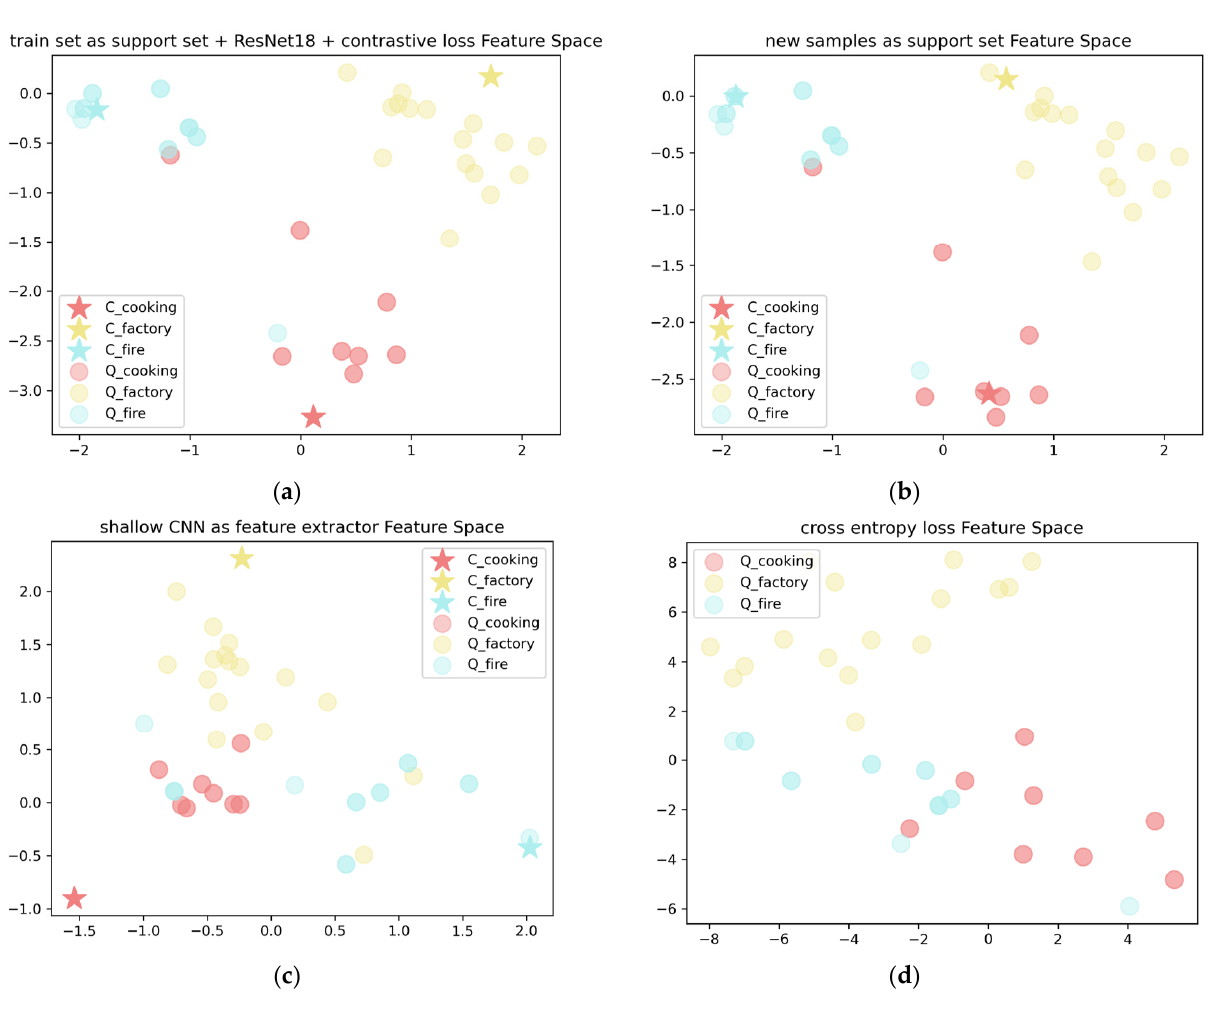
Figure 13. The comparison results are presented in the form of feature spatial distribution map. Table 2. Results of substitution comparison of major elements in the